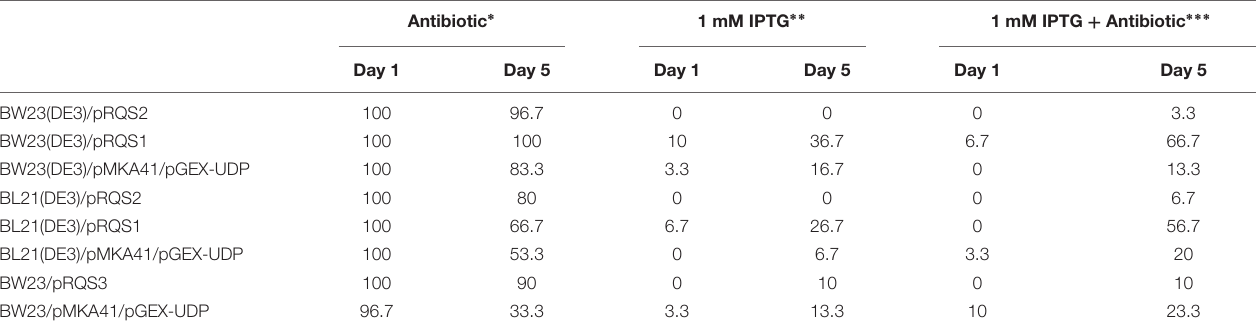
TABLE 1 | Plasmid stability comparison with antibiotic selection, IPTG induction, and combined IPTG induction and antibiotic